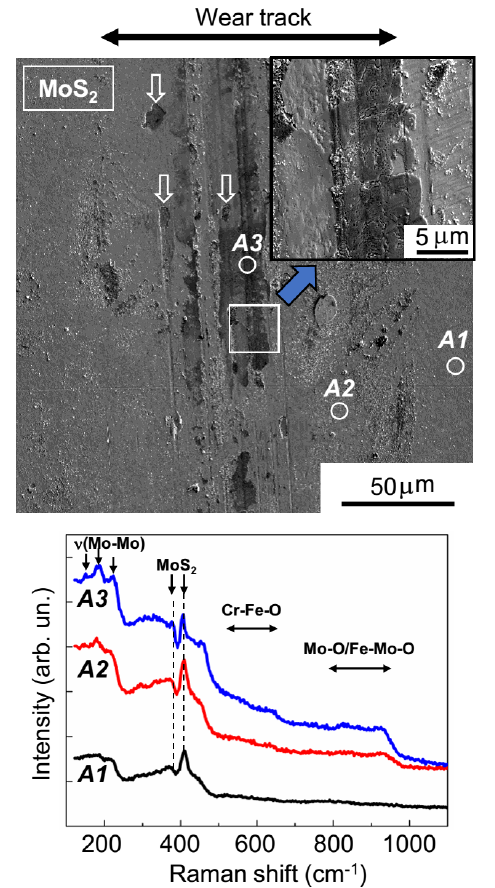
Figure 8. SEM image and Raman spectra for the MoS 2 coating subjected to tribo-testing at −100 °C in the argon–air mixture (RH ~ 9%). Raman spectra were measured on the unworn surface of the coating (area A1 ) and on the wear track surface (areas A2 and A3 ). In the figure, area A3 shows the wear debris that adhered to the surface of the track and was then deformed by the ball. The white arrows indicate micrometer-sized areas of local delamination on the MoS 2 coating.